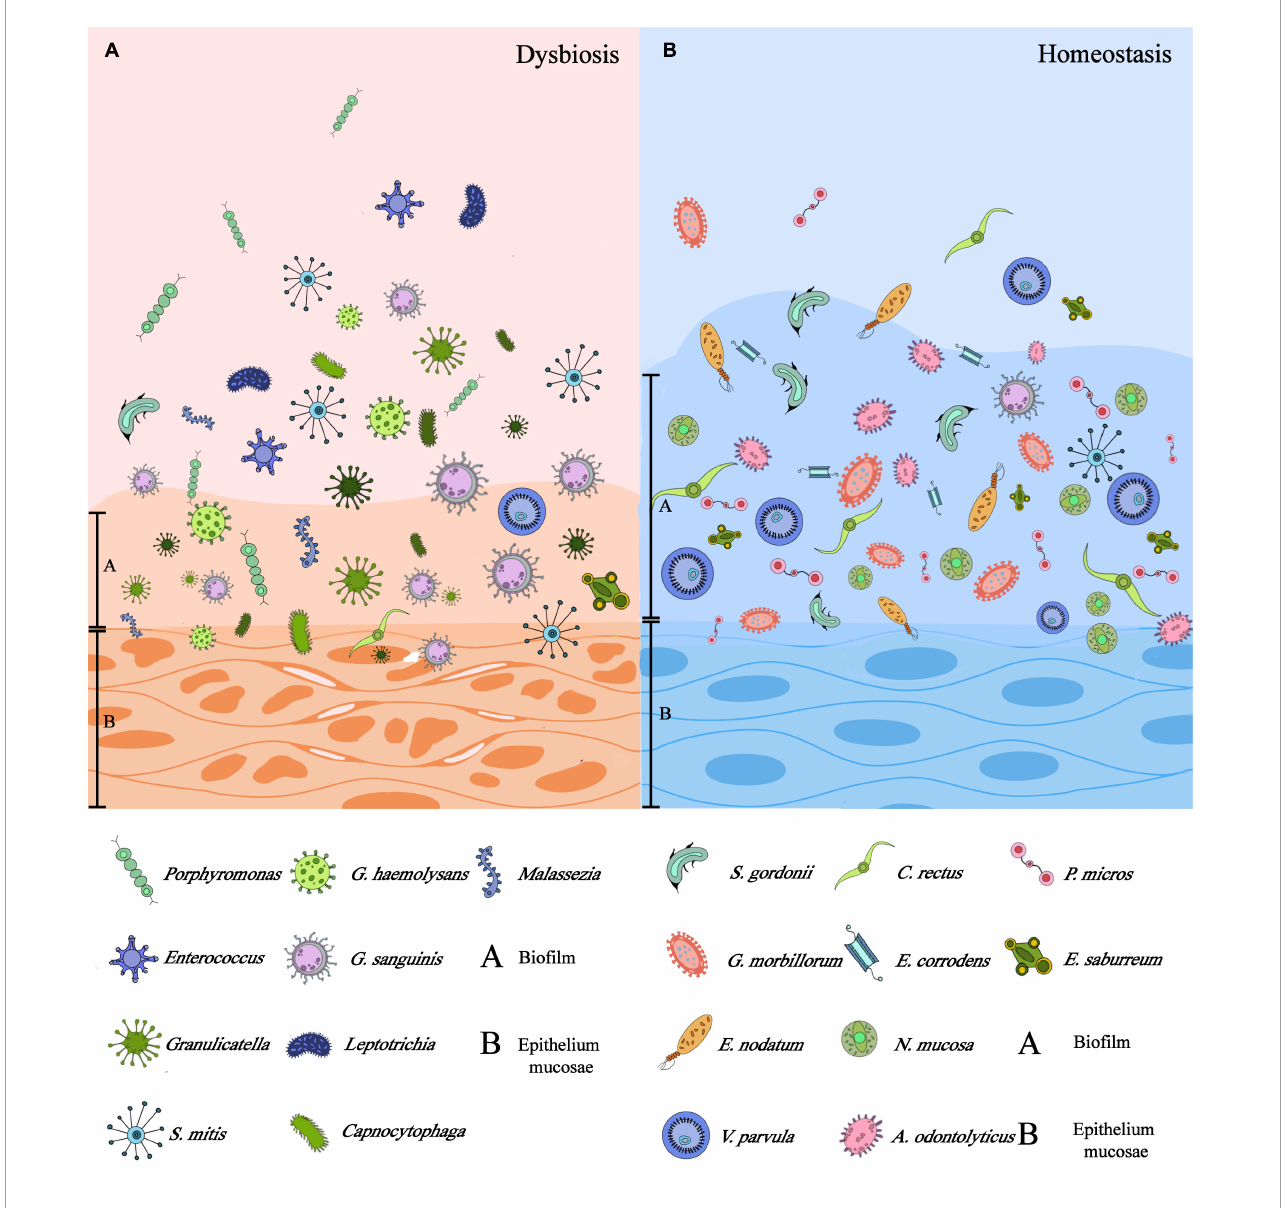
FIGURE1 Differences between dysbiosis and homeostasis of mucosal microbiota: (A) the dysbiosis of microbiota could be symbolized by the impaired epithelium, thinner biofilm attached to the epithelium, and dominant microflora being pathogens. (B) Microbiota homeostasis could be characterized by intact epithelium, thicker biofilm, and commensal microflora instead. (This figure was partially cited from Lin et al. (2021) with